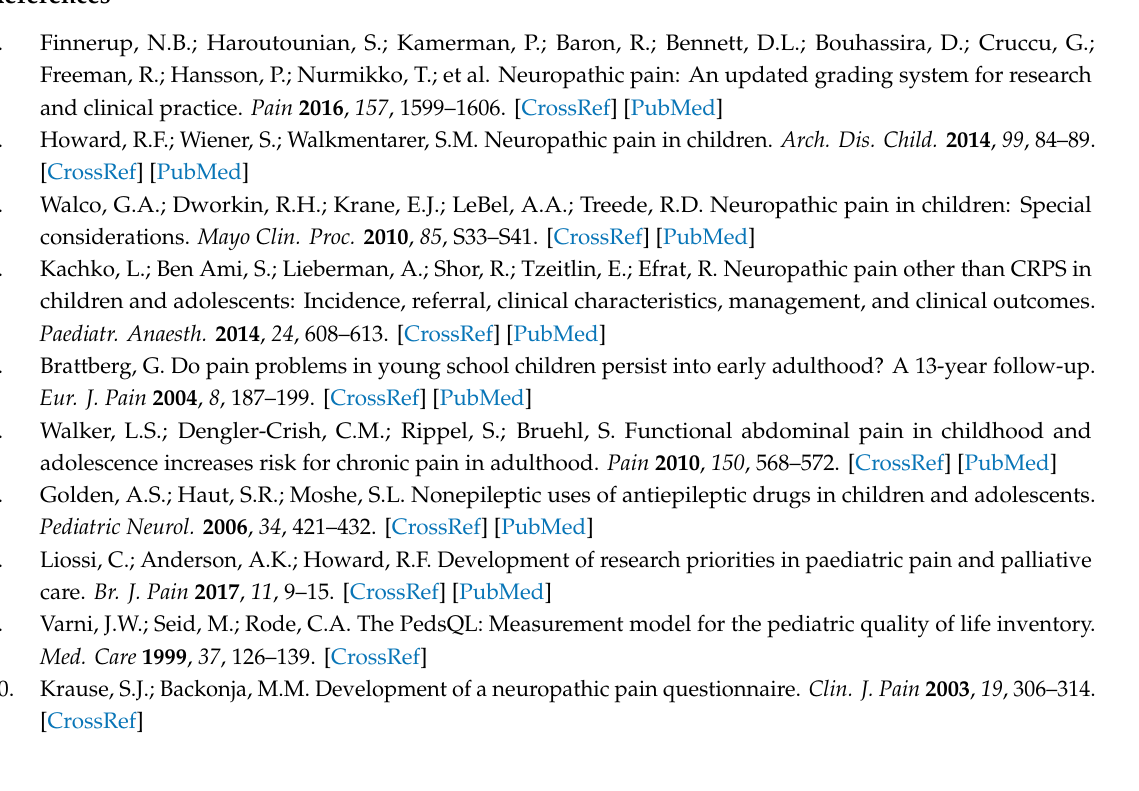
Figure S1: Questionnaire concerning the treatment of chronic neuropathic (or mixed) pain in children (the state of a ff